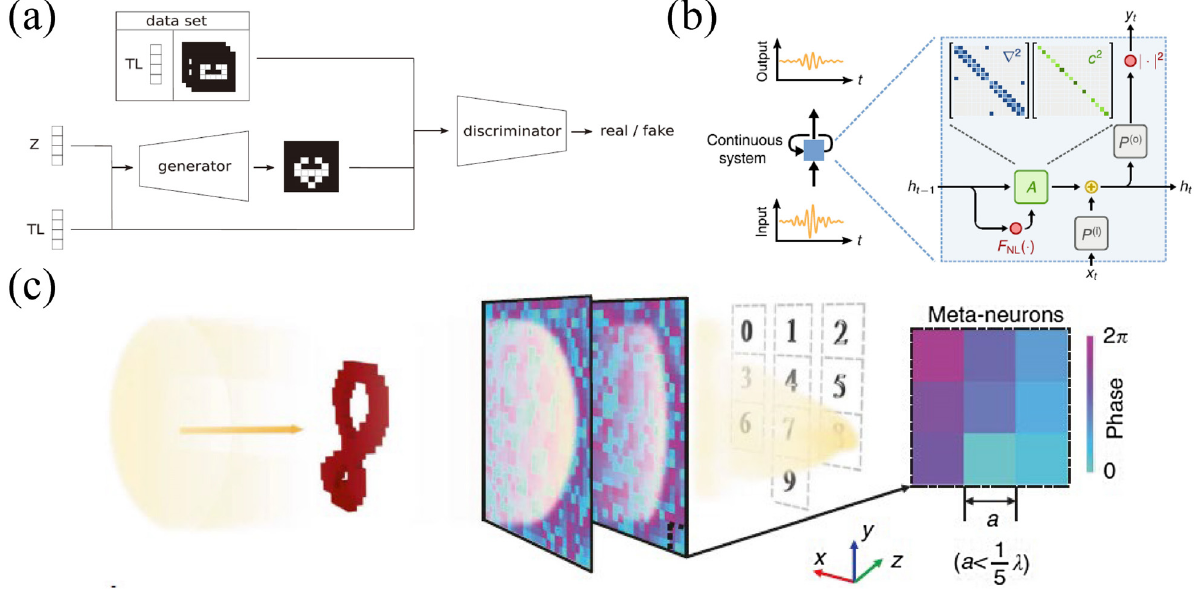
Figure 6: Advanced generative models frameworks in acoustic metamaterials and simulation of wave physical mechanism with neural network